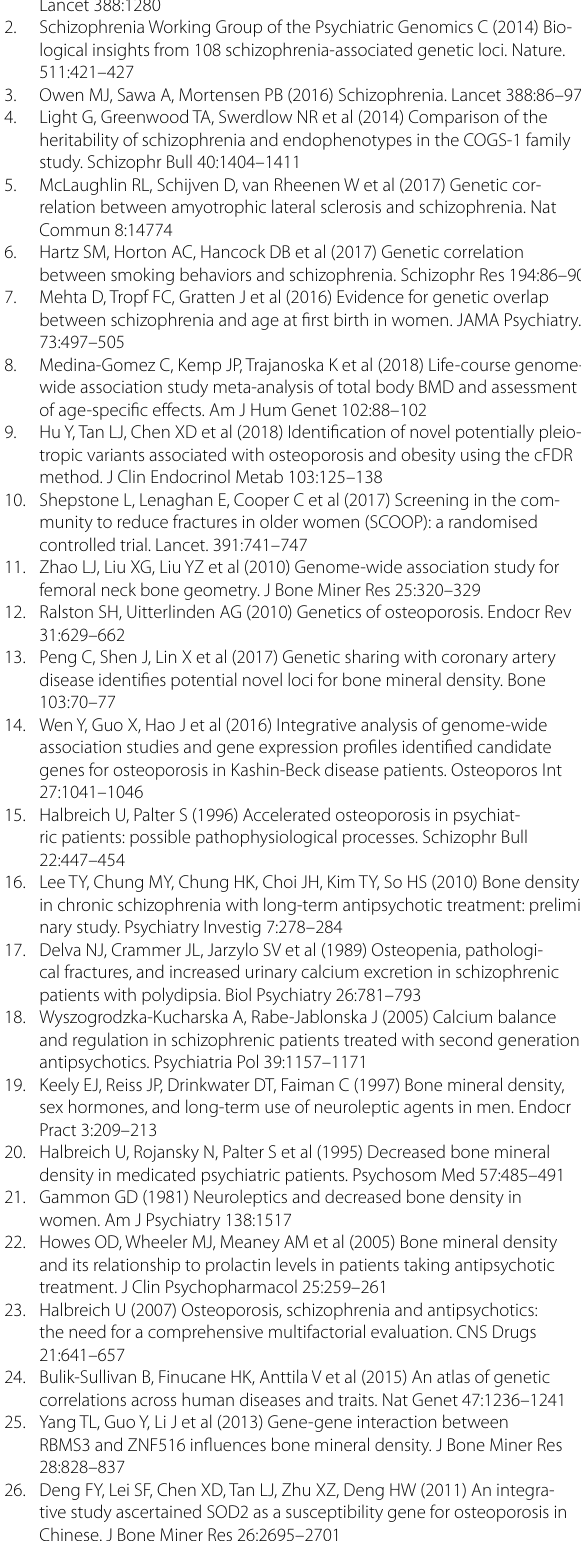
Additional file 7: Table S7. FUMA gene set enrichment analysis results for the association between Ulna & Radius area and